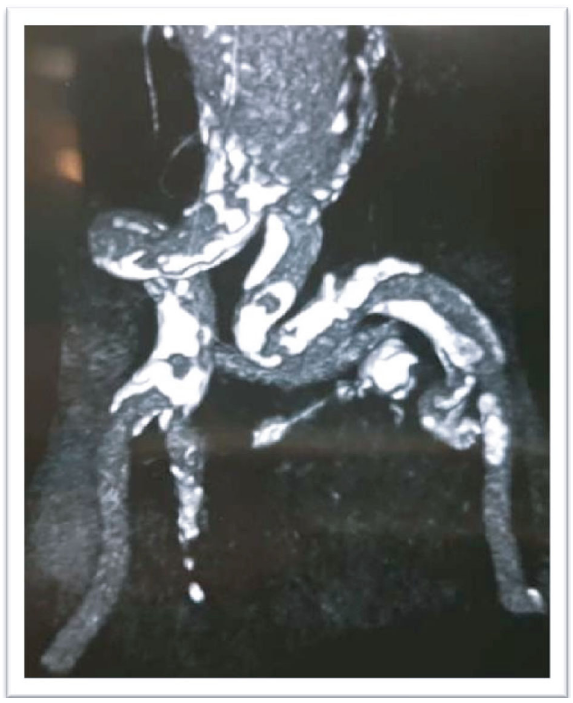
Figure 2: Abdominopelvic CT scan without contrast before AAA repair operation.